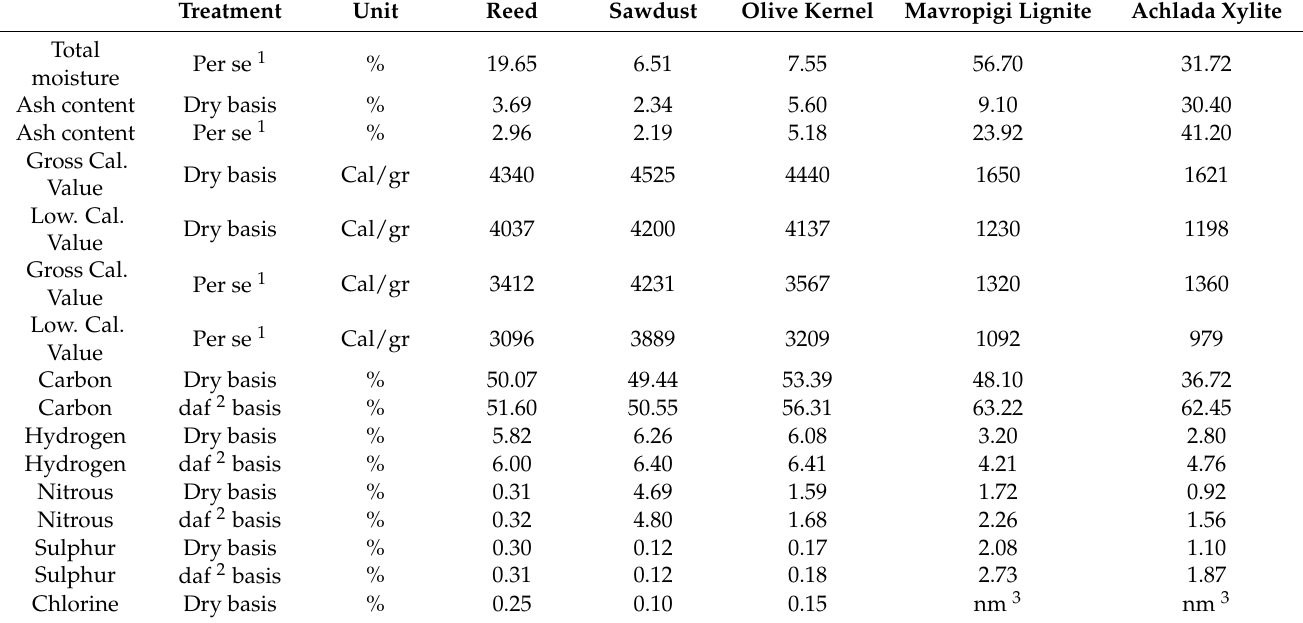
Table 2. The results of proximate and ultimate analyses and the calorific values of the biomass and lignite samples